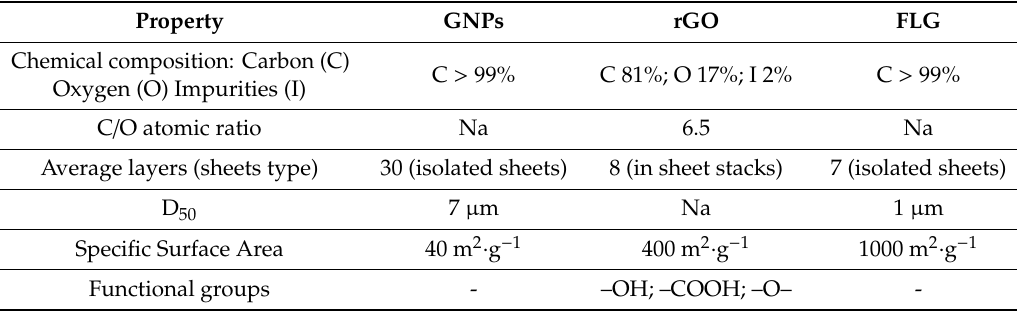
Table 1. Main characteristics of the three graphenic nanomaterials used.